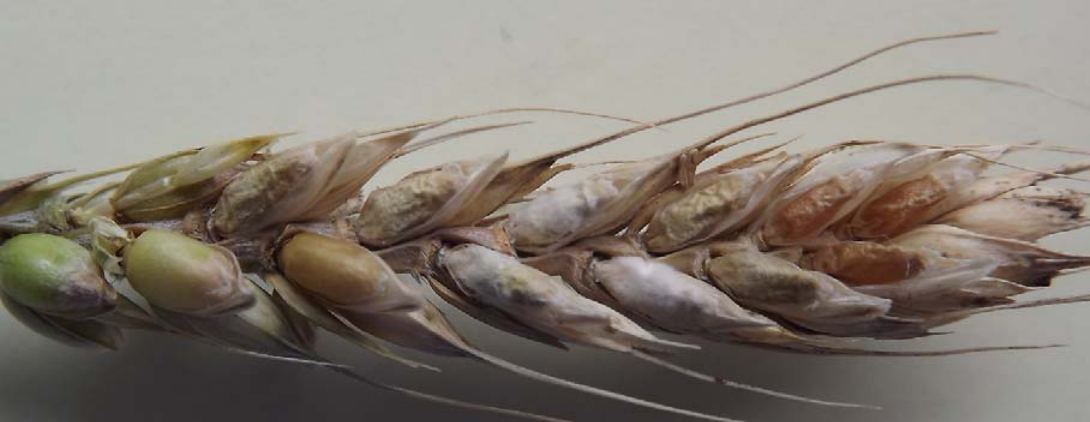
Figure 14. Ear of a highly susceptible genotype. At the bottom, normal green ‐ colored, full sized grain, even the head axis is damaged to some extent. One spikelet higher, the grain starts to show early ripening discoloration, but it is still full size. The next spikelet is infected, the green color covered by mycelium, and shriveled. The next spikelet is light brown close to waxy ripening. Thereafter, there are four strongly infected spikelets with massive mycelium coverage, then, two infected grains similar to the second one from the bottom, and at the top three strongly shriveled, but bleached normal colored, not directly infected, grains.